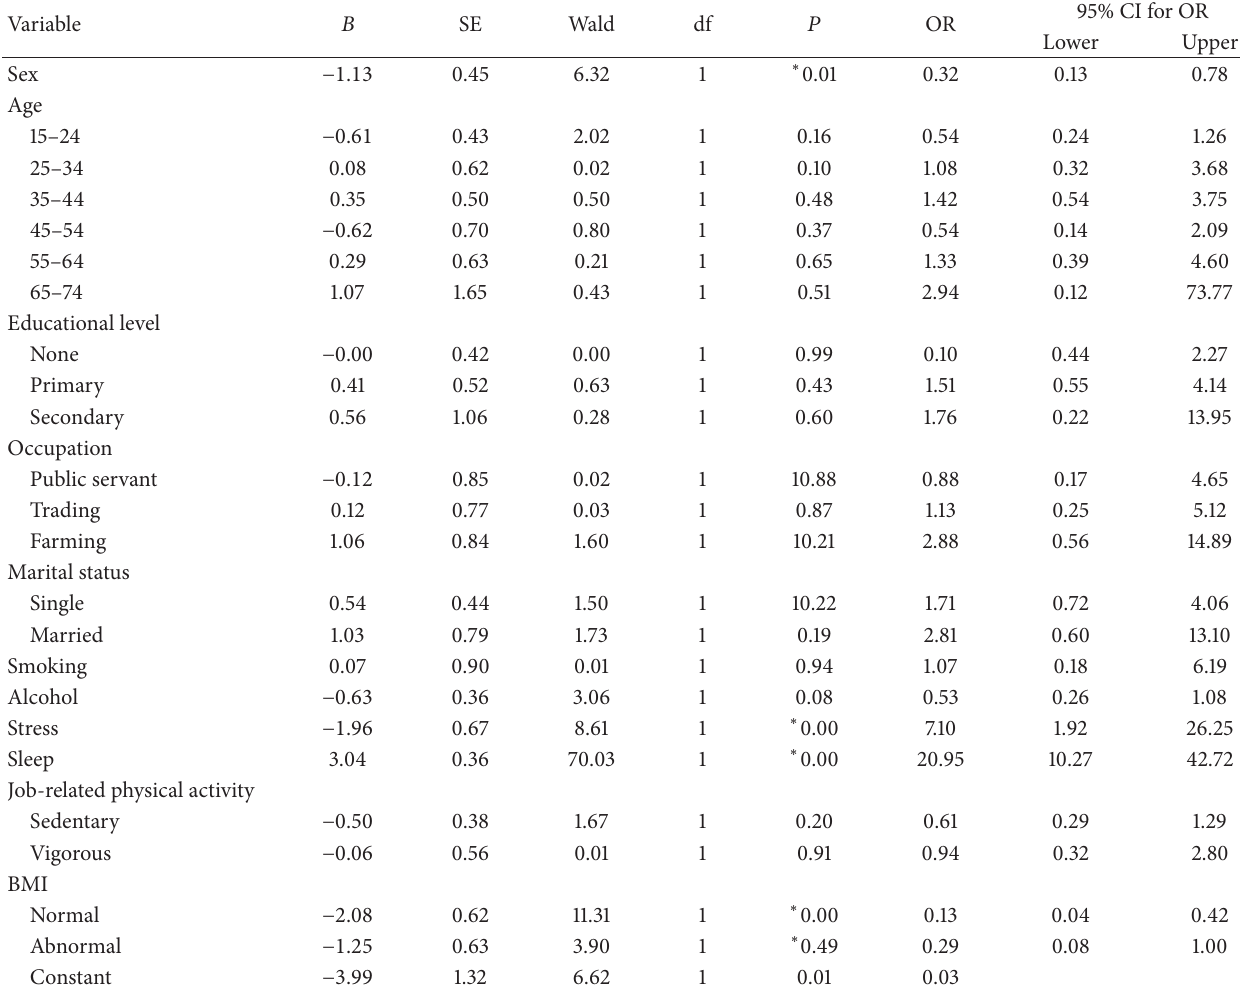
Table 4: Logistic regression model predicting likelihood of modifiable risk factors for hypertension.